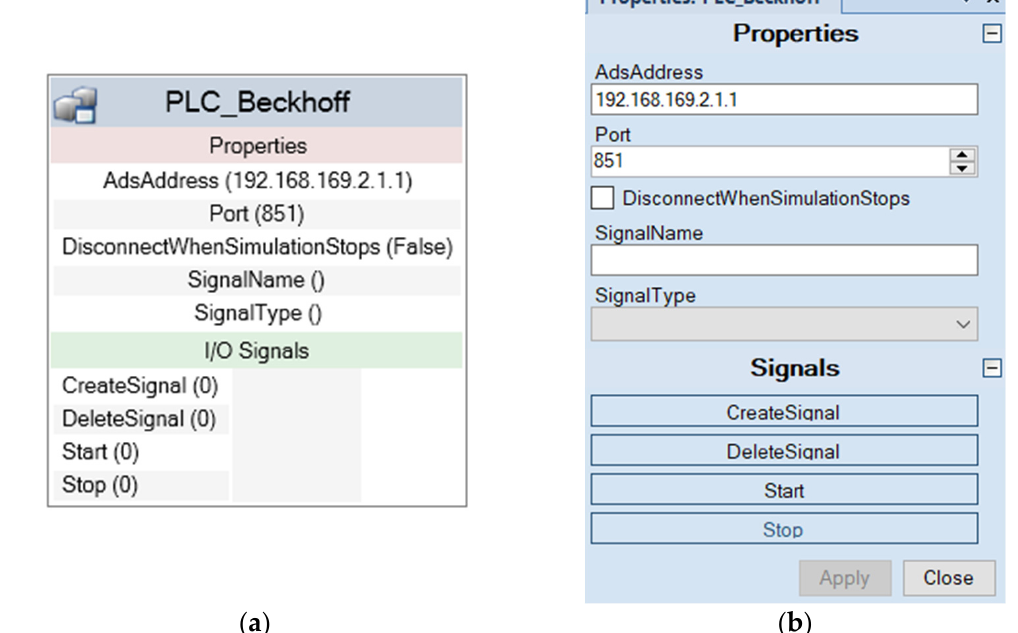
Figure 3. Default appearance of the PLC_Beckhoff SC in RS. ( a ) Graphic user interface of the SC in the Station Logic section of RS: in the figure, no signal to be exchanged with the PLC has yet been defined; ( b ) SC in edit mode: the user can use this form to configure ADS connection options and create signals that are required for specific applications.